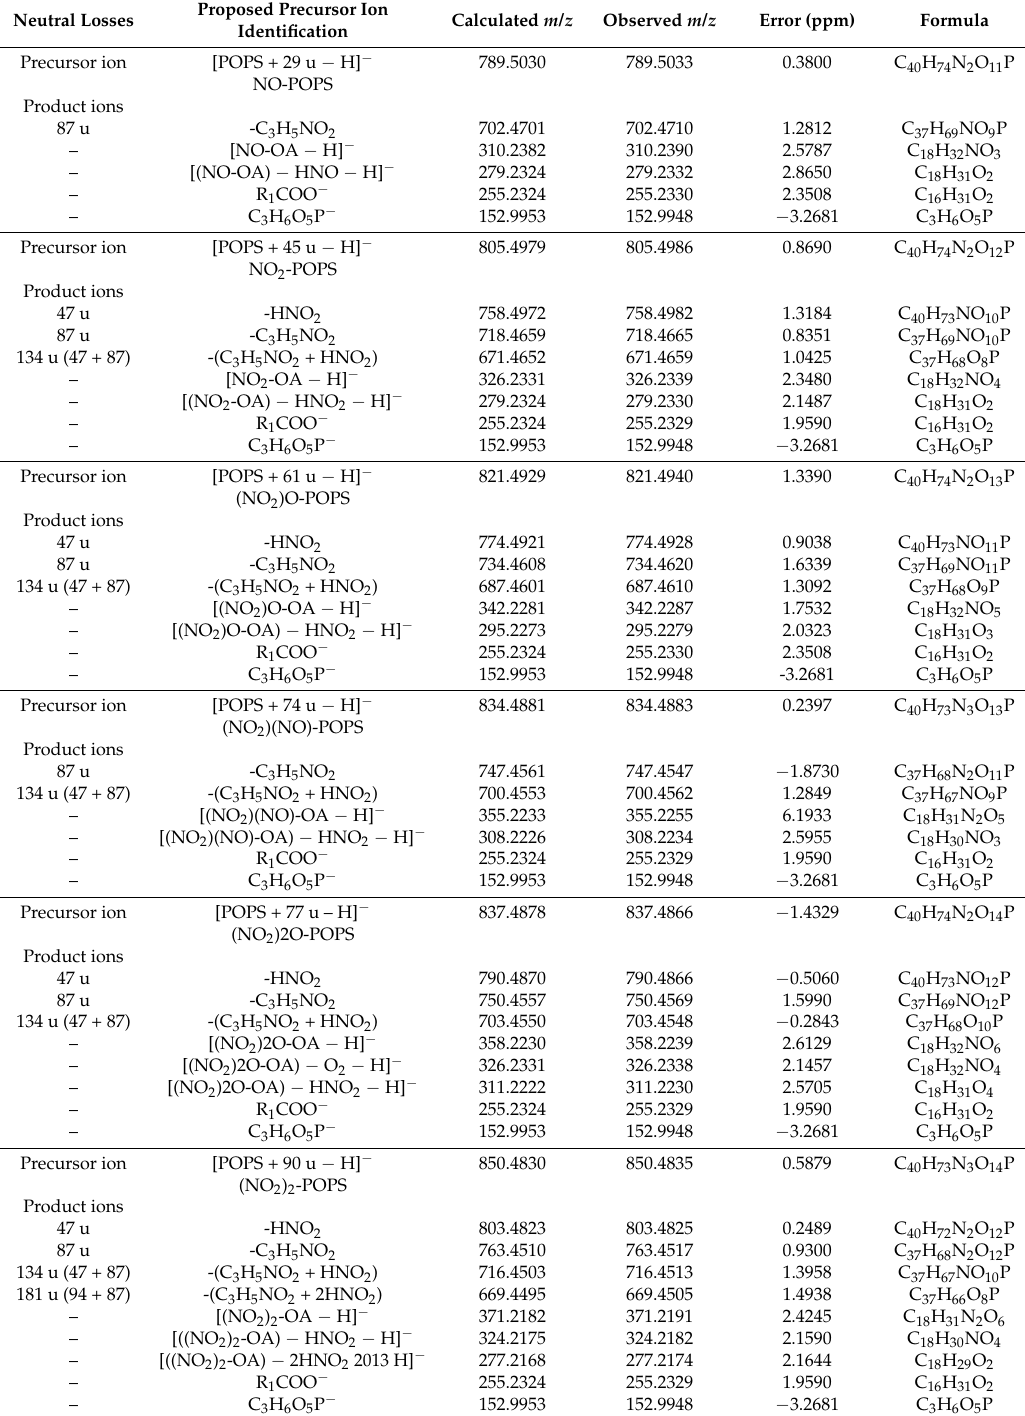
Table 1. Neutral losses and product ions observed in the ESI-MS/MS spectra acquired in the Q-Exactive Orbitrap mass spectrometer (HCD) of the nitrated and nitroxidized derivatives formed after reaction between NO 2 BF 4 and POPS, with the proposed identification, calculated and observed mass, error, and formula. Error (ppm) = (Observed m/z − Calculated m/z )/Calculated m/z ) × 1 × 10 6